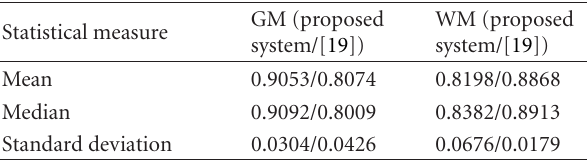
Table 2: Comparison: mean, median, and standard deviation for GM and WM tissues using di ff erent